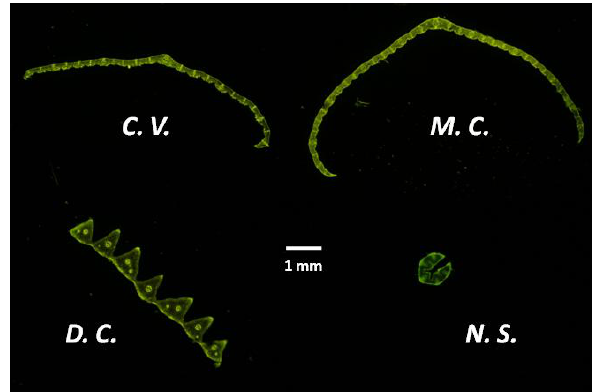
Figure 4. Anatomical sections of all the studies species – examples from August 2020. Hand-microtome fresh leaves